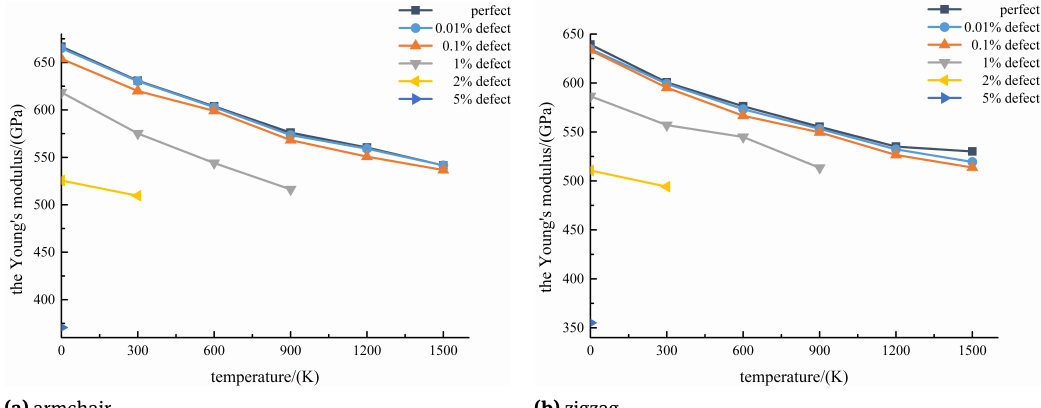
Figure 10: Young’s modulus as a function of temperature with different percentage of vacancy